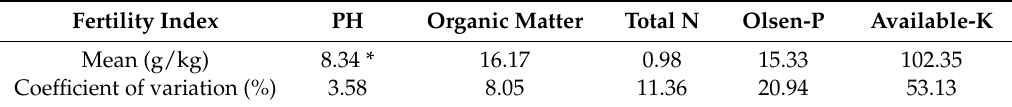
Table 1. Chemical properties of the 0–20 cm top soil in the study site (n = 70). Fertility Index PH Organic Matter Total N Olsen-P Fertility Index PH Organic Matter Total N Olsen-P Available-K Coefficient of variation (%)